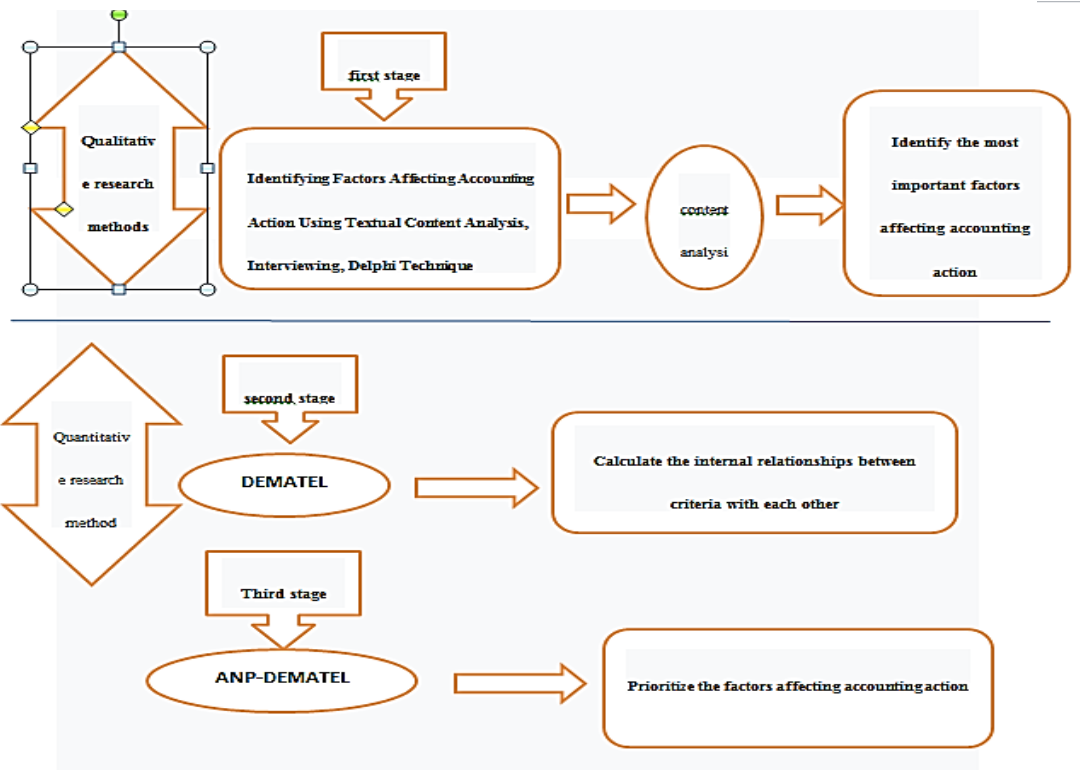
Fig. 1. Research process in two phases, qualitative and